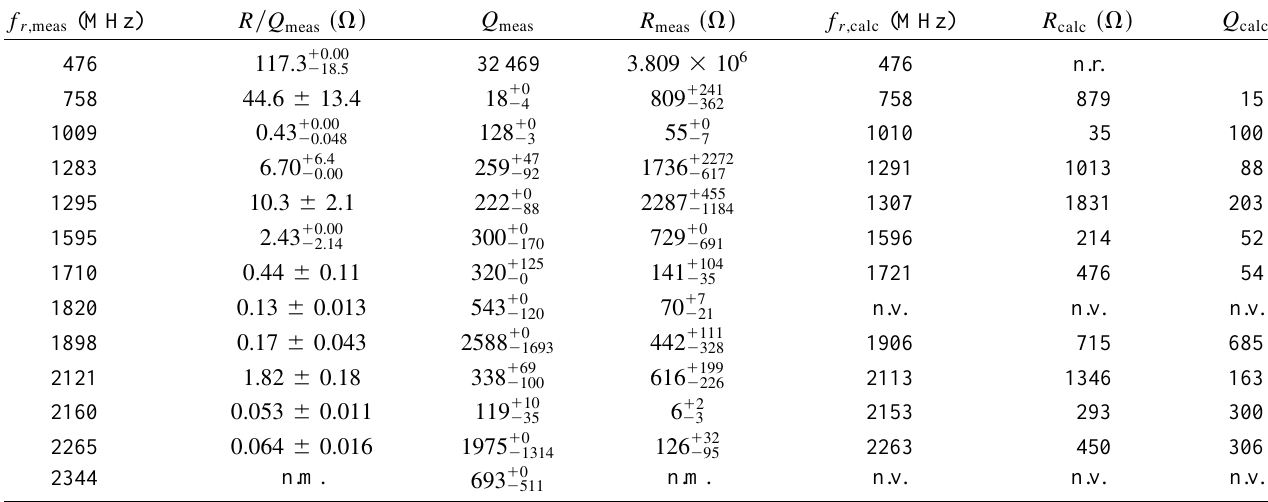
TABLE I. Impedance and Q ’s of monopole modes estimated from calculations and measurements. R (cid:1) V 2 (cid:1) 2 P . n.m. (cid:1) not measured, n.v. (cid:1) not visible, n.r. (cid:1) not resolved in time domain simulation. f r ,meas (MHz)